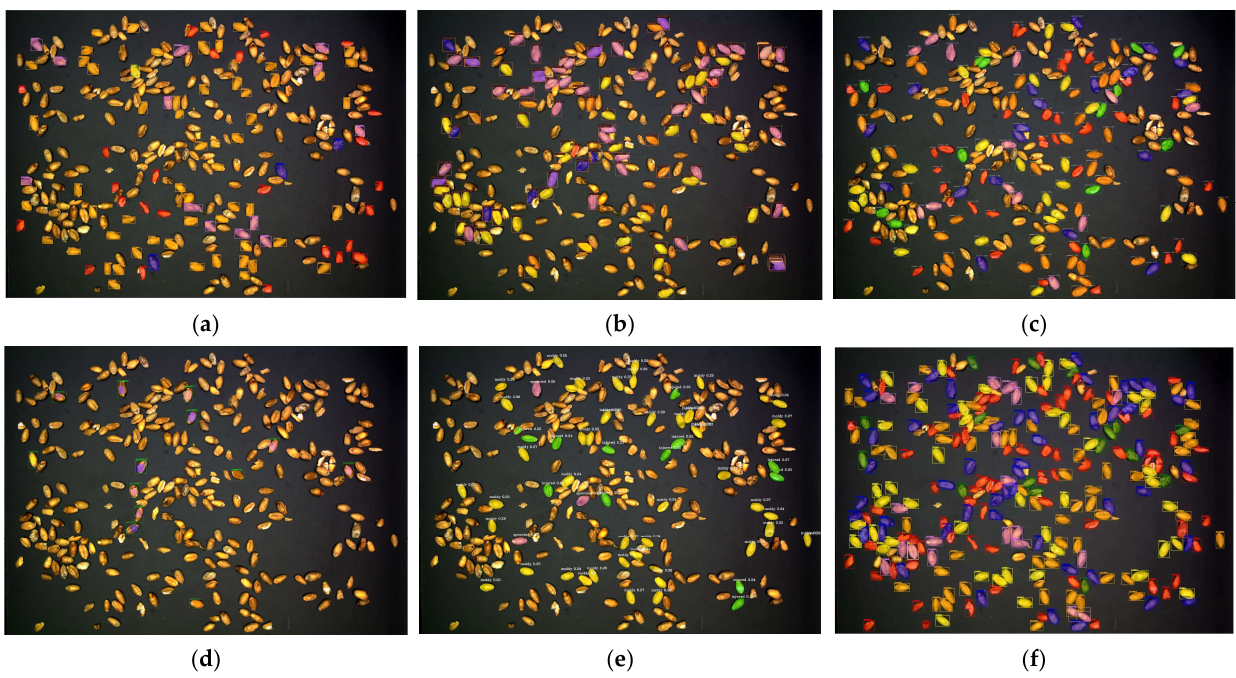
Figure 9. Result images. ( a ) Original image. ( b ) Result images of Swin Transformer. ( c ) Result images of mask scoring RCNN. ( d ) Result images of polar mask. ( e ) Result images of SOLO. ( f ) Result images of ours (representations of color boxes are as follows: orange: perfect kernels; yellow: moldy kernels; red: broken kernels; purple: sprouted kernels; blue: spotted kernels; green: injured kernels).